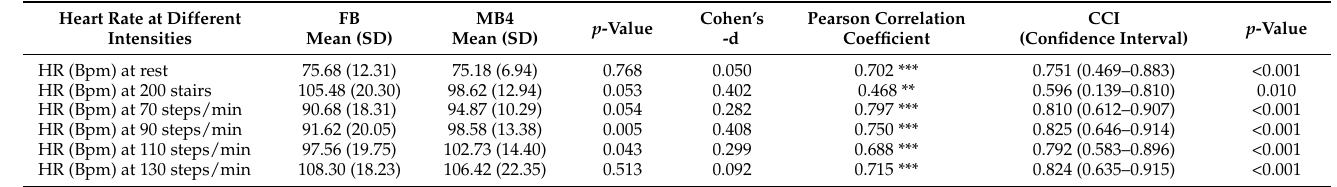
Table 3. Validation statistics of HR recorded by comparing FB monitors and Xiaomi MB4 wristband.